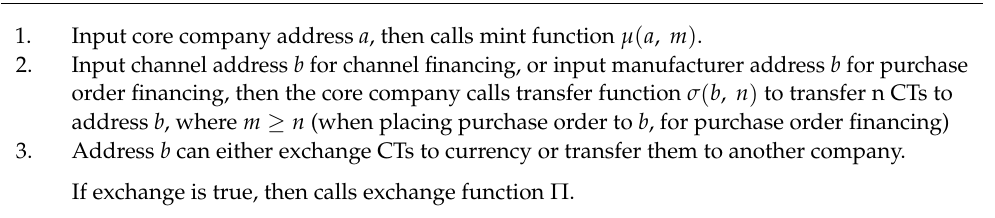
Algorithm 1 The processes and the operations of advance